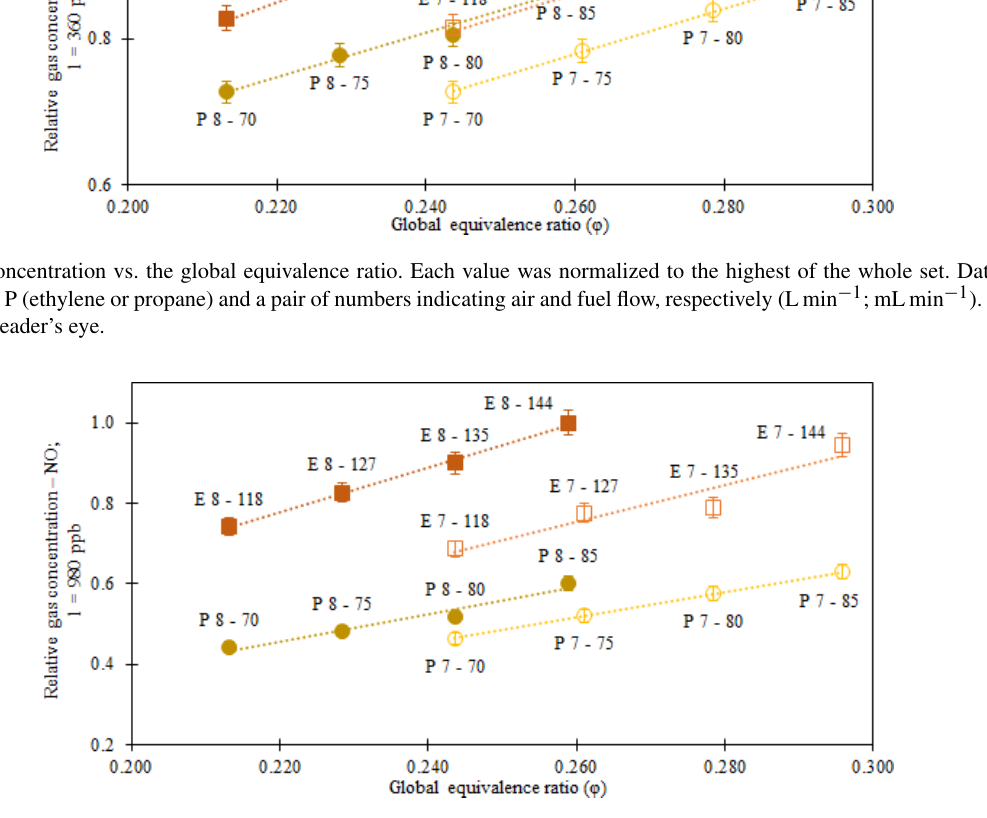
Figure 8. NO concentration vs. the global equivalence ratio. Each value was normalized to the highest of the whole set. Data points are labelled with E or P (ethylene or propane) and a pair of numbers indicating air and fuel flow, respectively (Lmin − 1 ; mLmin − 1 ). Dotted lines aim to guide the reader’s